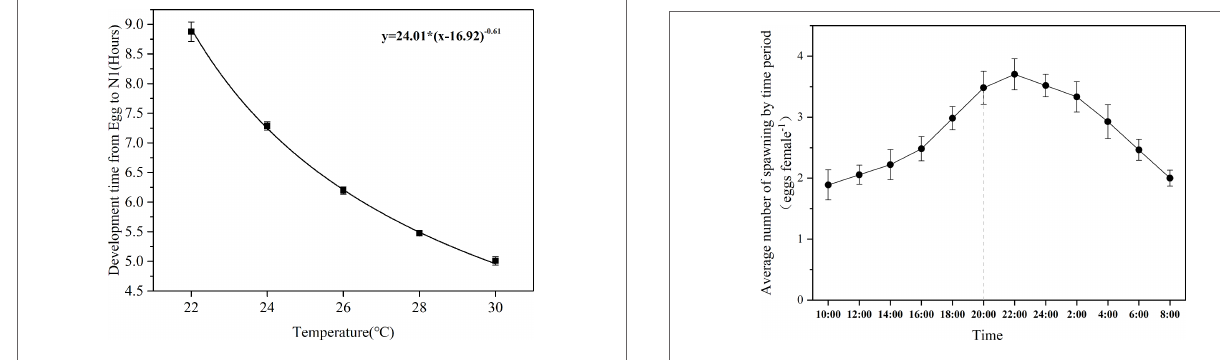
FIGURE 3 | The daily spawning rhythm of B. amoyensis . Data are presented as mean± standard error (SE). The dotted line is the point in time when the dark period is